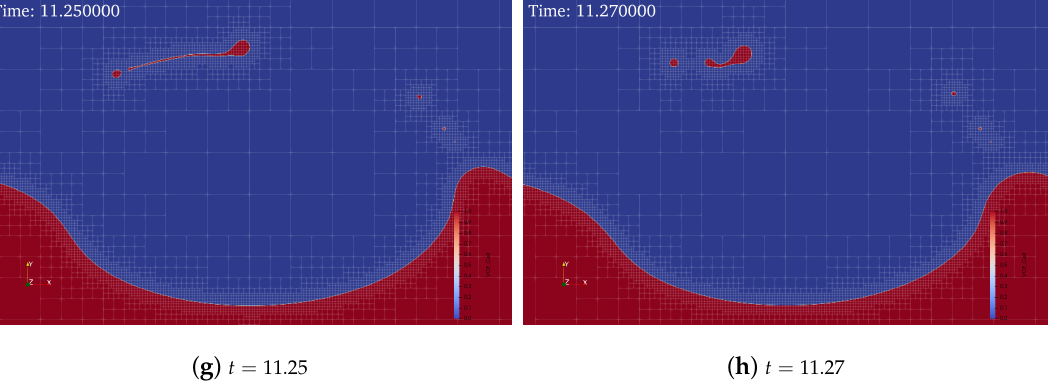
Figure 16. Volume fraction profile focused on the liquid film area during the rupture process of the liquid film in surfactant solution with a Langmuir number of La = 15 from t = 11.13 to t = 11.27 with an interval of ∆ t = 0.02. The region presented in red contains heavy fluid, and the region presented in blue contains light fluid. The AMR leaves are shown as light grey